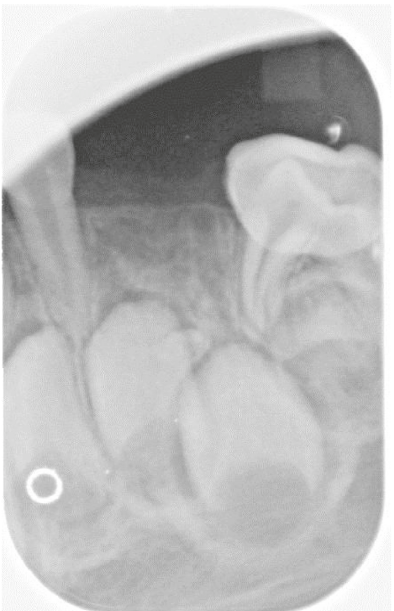
Figure 4: The tribal leader extirpated the lower left primary canine, but there appears to be a remaining tooth-like